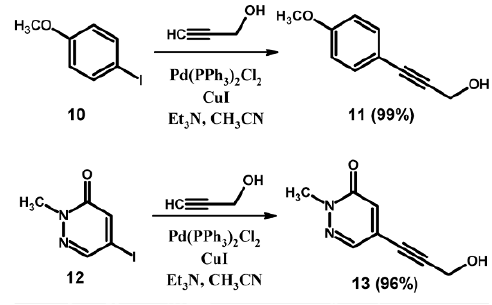
Scheme 2. Synthesis of the fluorescent dansyl derivative ( 9 ).